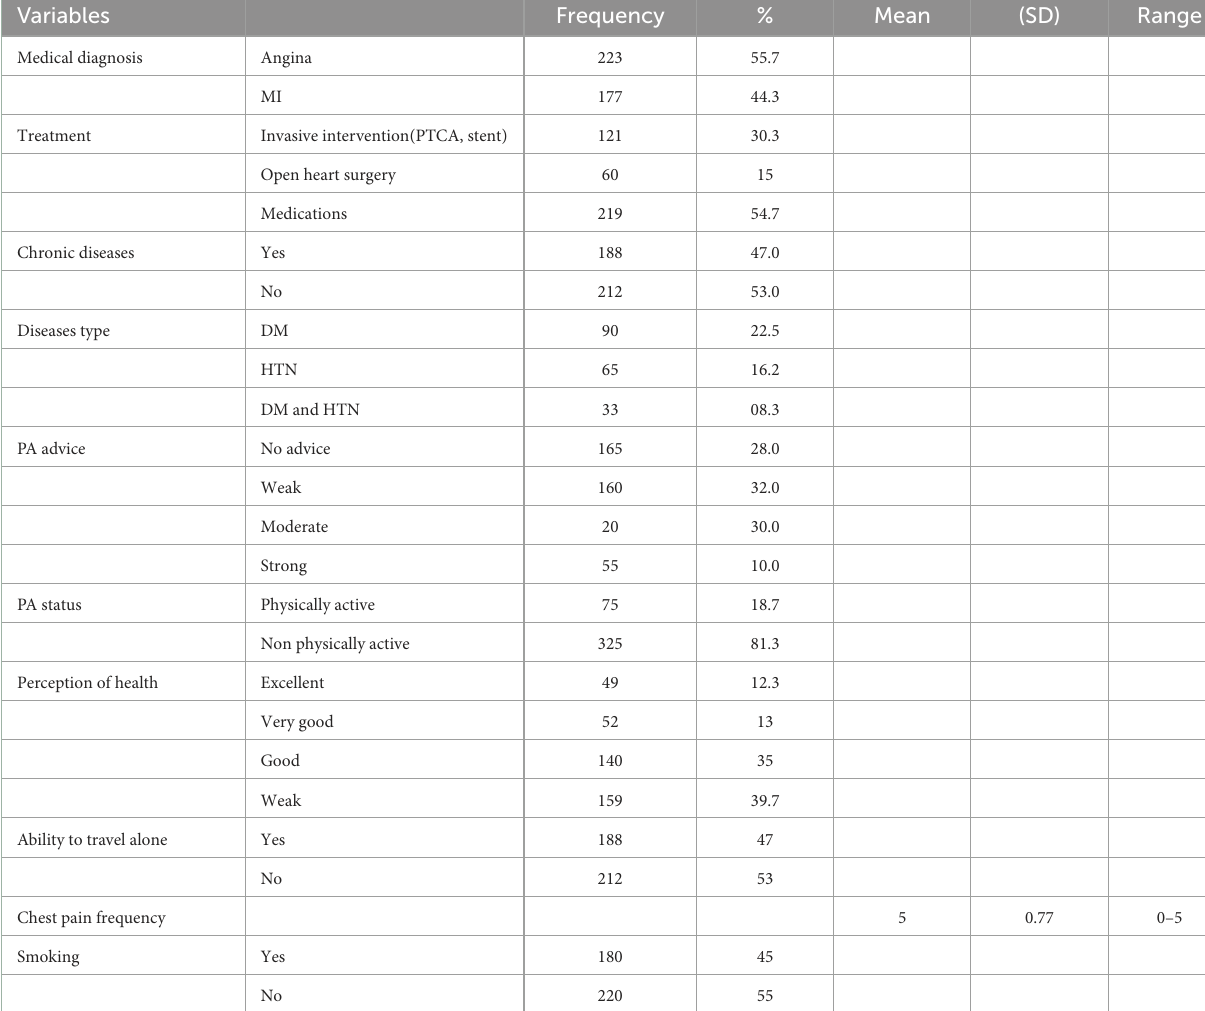
TABLE 2 Health characteristics of the sample ( n = 400).